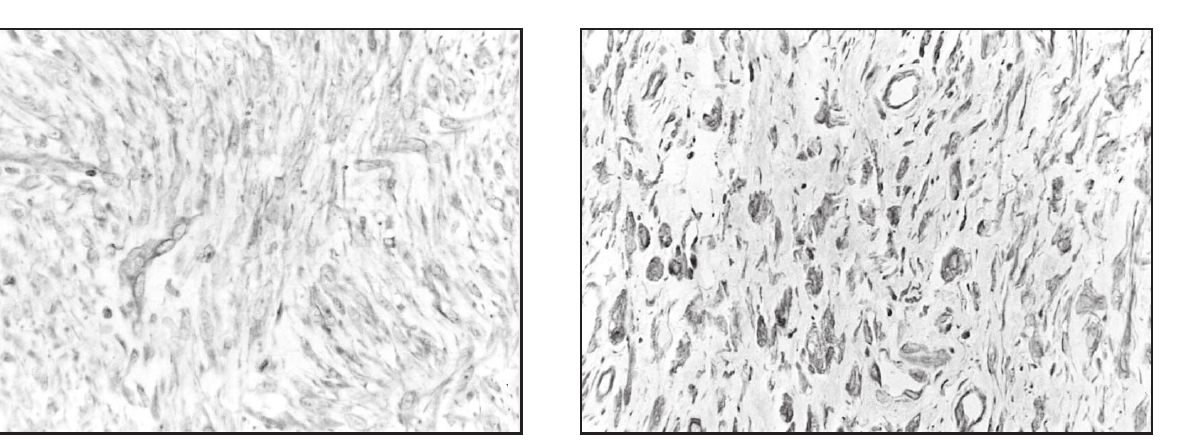
Figura 8 – Caso 2/vimentina. Todas as células neoplásicas exibindo marcação fortemente positiva para o anticorpo (100x)